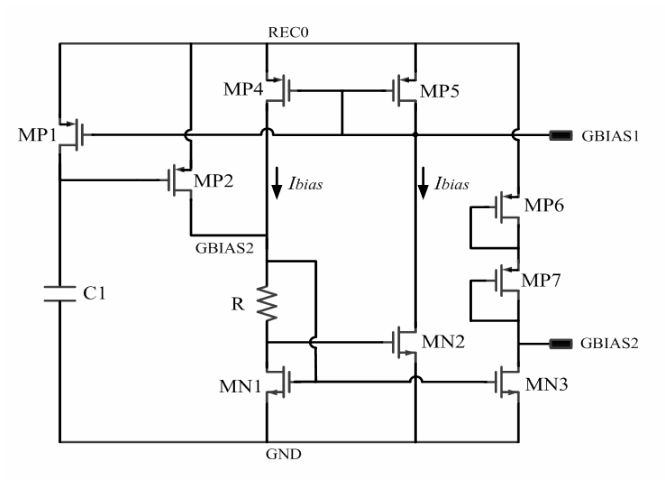
Figure 5. Bias circuit of RF powering